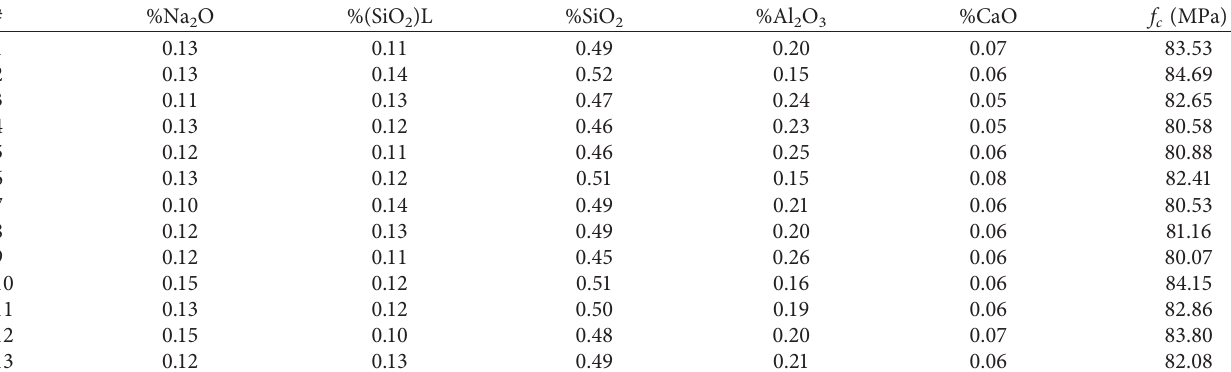
Table 7: Predicted inputs corresponding to mortar compressive strength f